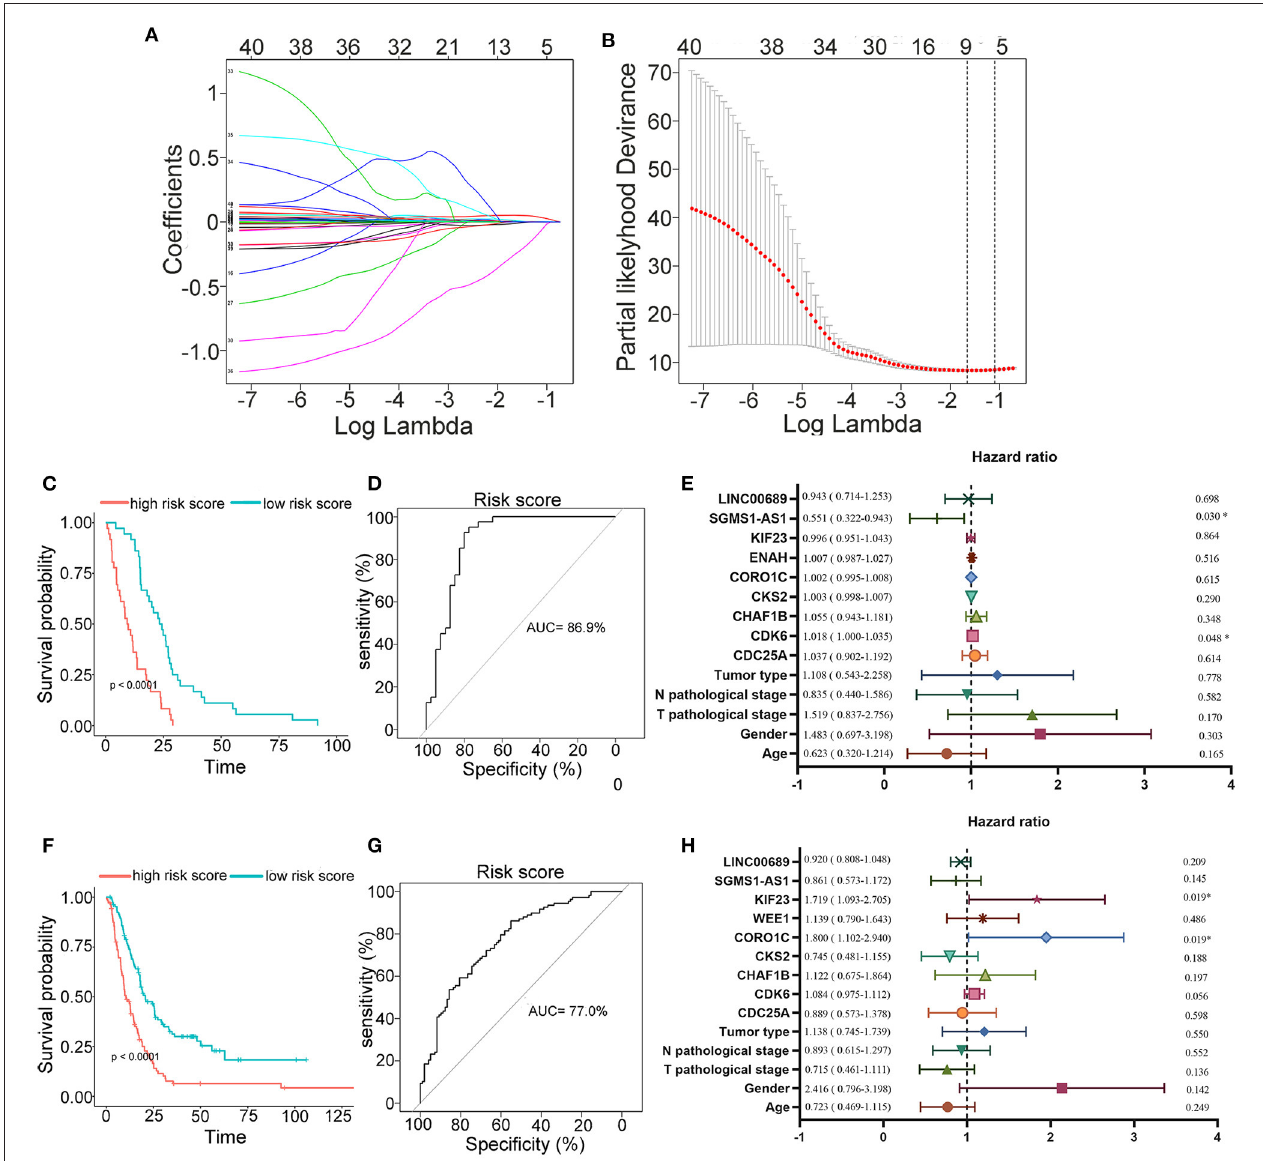
FIGURE 5 | Construction, estimation, and validation of the risk model. (A) Least absolute shrinkage and selection operator (LASSO) coefficient profiles of the 40 genes. The value was chosen by 10-fold cross-validation. (B) The numbers above the graph represent the number of genes involved in the LASSO model. (C,D) Survival curve and ROC curve of the risk model according to the dataset of EGA. (E) Forest plot showing associations between the selected nine genes, the reported clinical factors, and the overall survival in the model. (F–H) Validation of the risk model based on the survival curve, the ROC curve, and the multivariate Cox analysis according to the EGA dataset. The significances of the survival curves were calculated by log-rank test. Also, the AUC values of ROC curves > 70% were regarded as efficient models.